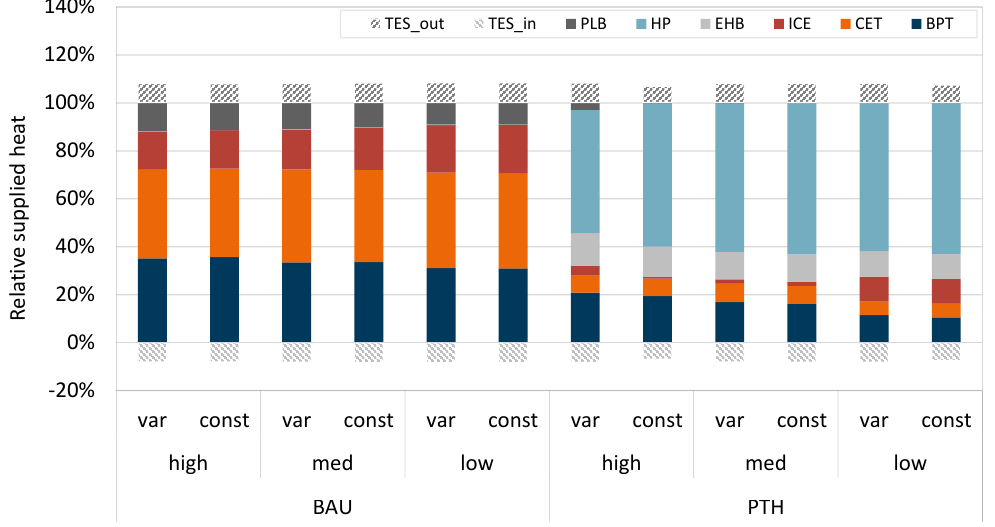
Figure 6. Annual heat supply aggregated by scenario, temperature level, and modeling